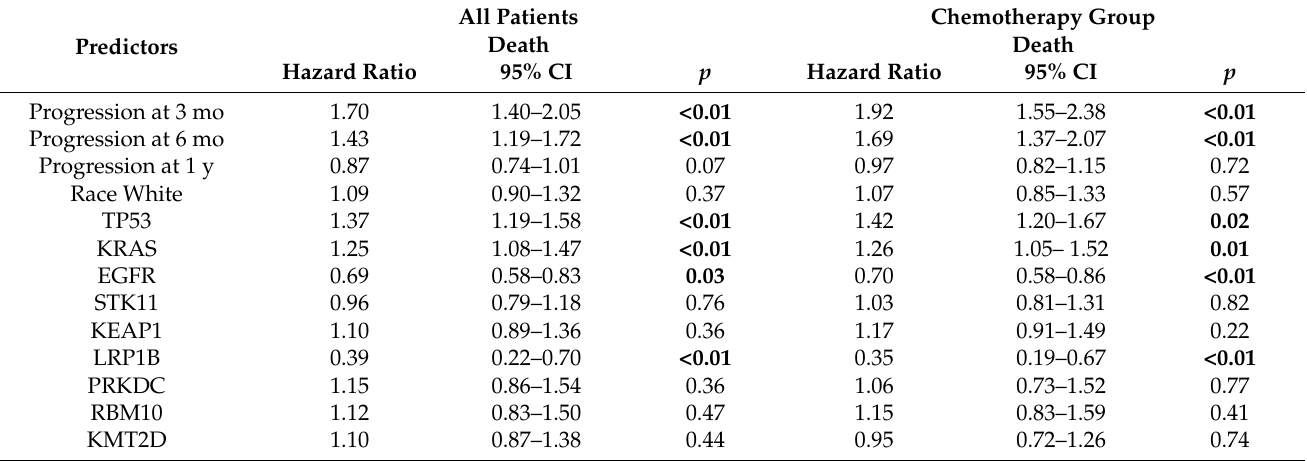
Table 4. Cox regression for